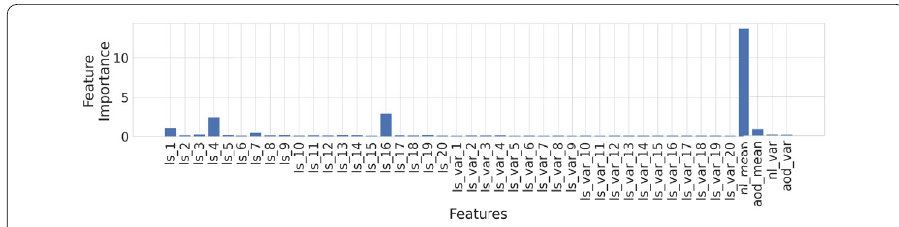
Figure 5 Feature relevance obtained using AutomaticRelevanceDetermination (ARD) kernel, which is often used for this task in GPs, where the inverse length scale parameter of each input variable is used as a proxy for feature relevance [40]. nl refers to nighttime lights, aod refers to aerosol optical depth and ls refers to landsat features